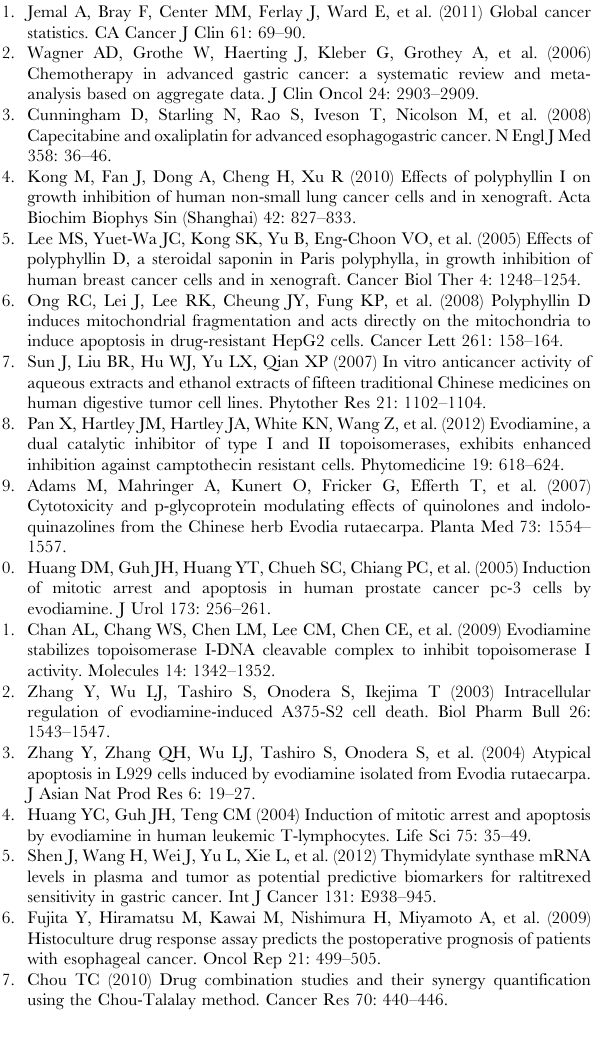
Figure S1 The RT-PCR amplification curves of different genes.